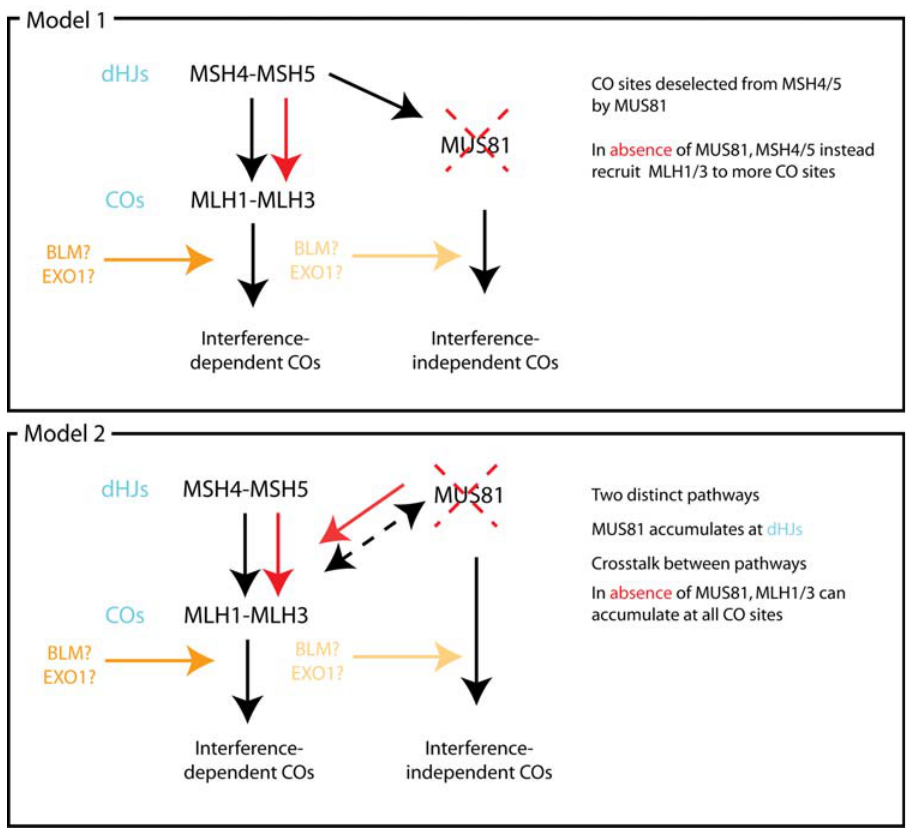
Figure 7. Two possible models for late action of MUS81 in mammalian meiosis.